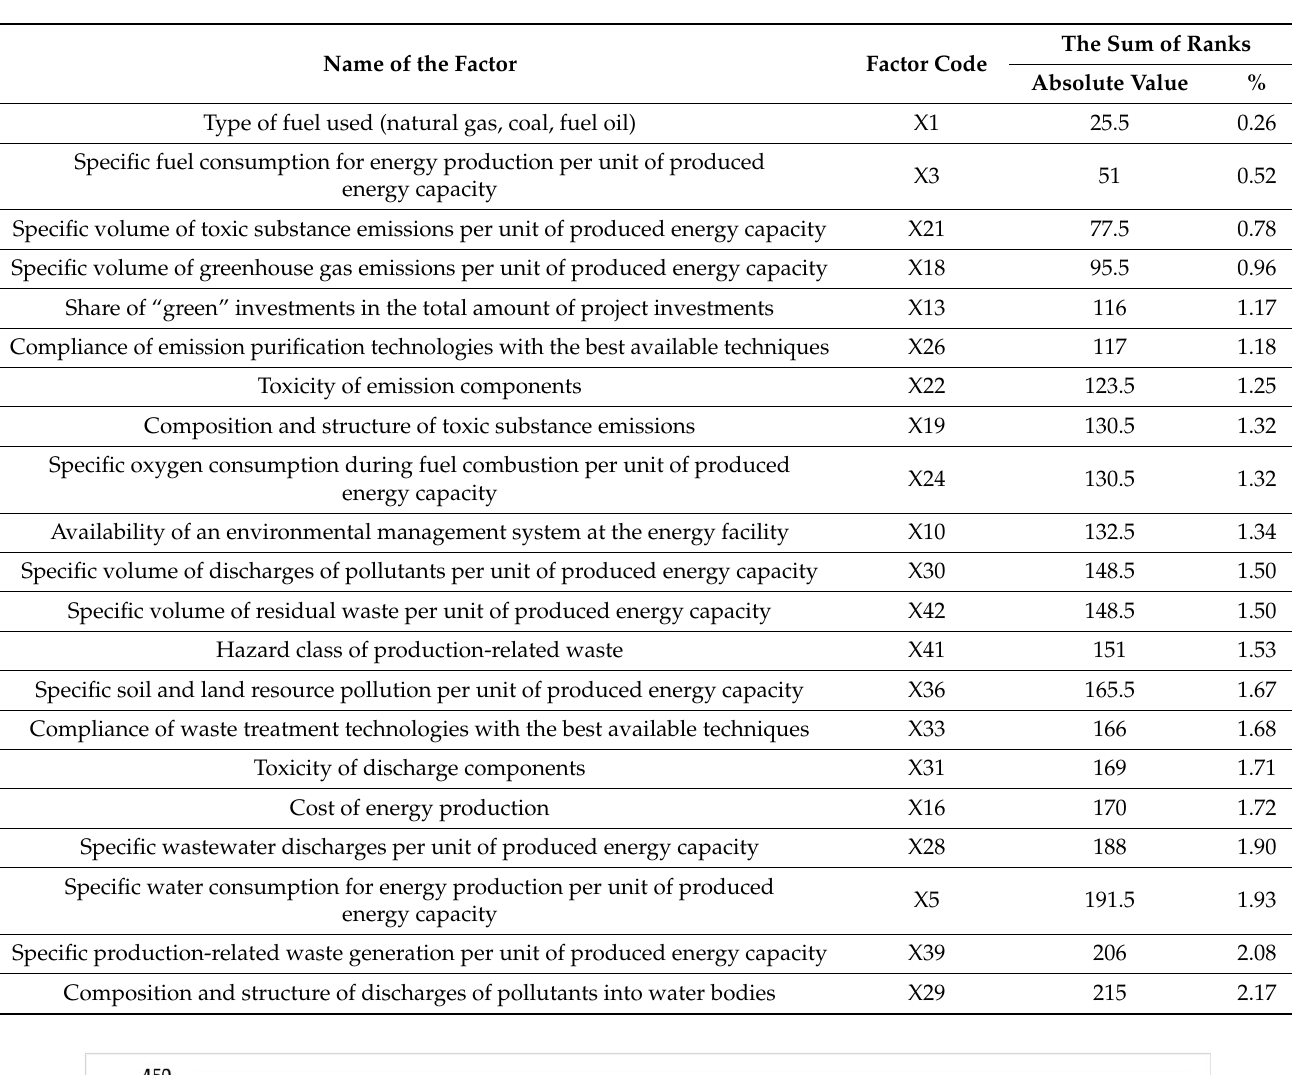
Table 3. The results of a priori ranking of factors for environmental and economic evaluation of energy investment projects.